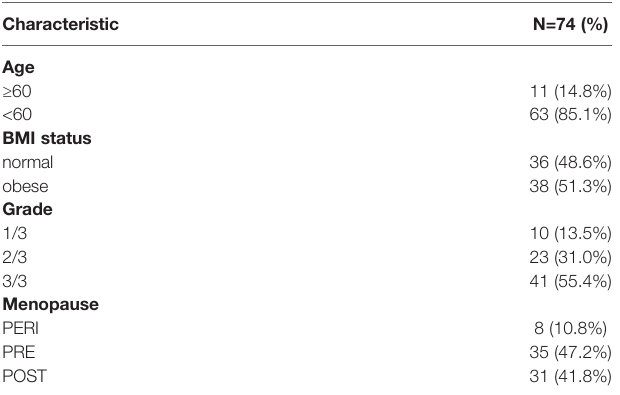
TABLE 1 | Sample information in the GSE24185 dataset.